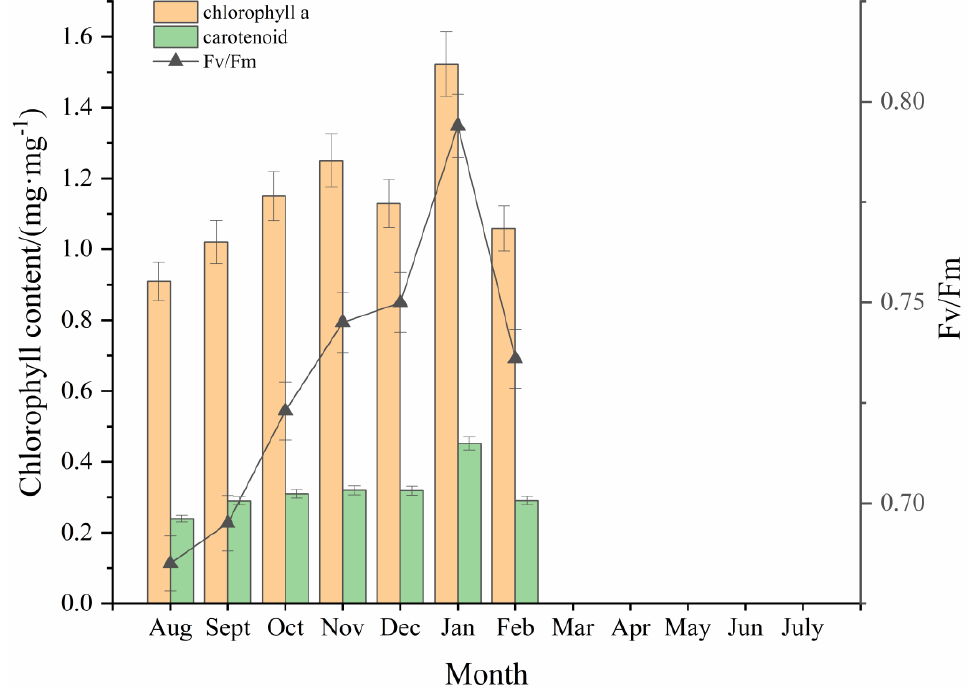
Figure 5. Variation in chlorophyll A, carotenoid content, and Fv/Fm in the leaves of attached S. horn- eri